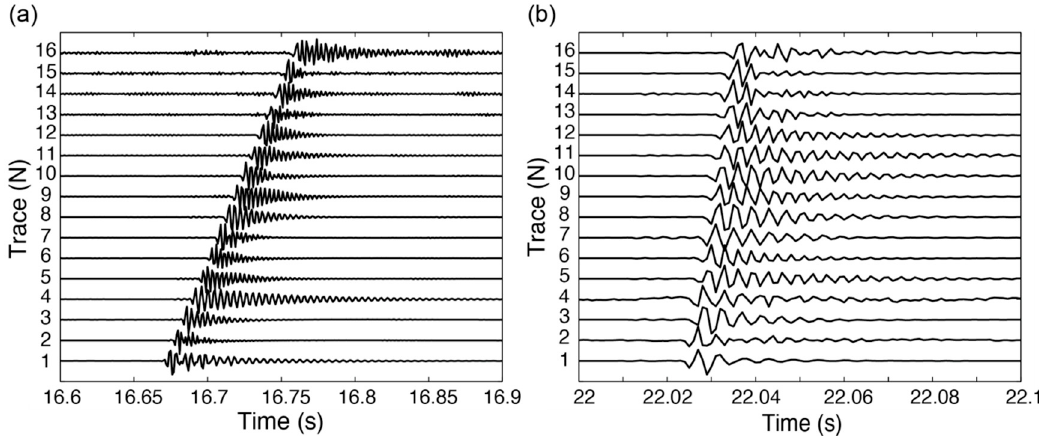
Figure 4. Vertical normalized seismograms of the hammer hitting recorded by the 16 fiber optic seismometers with intervals of 10 m ( a ) and 1 m ( b ). The offsets between the seismic source of hammer hitting and the seismometer No. 1 are 15 m in ( a ) and 50 m in ( b ). The origin times of seismograms are 16.6 s at 12:36 p.m. on 8 August ( a ) and 22.0 s at 11:47 a.m. ( b ) on 9 August 2021 in Beijing time.